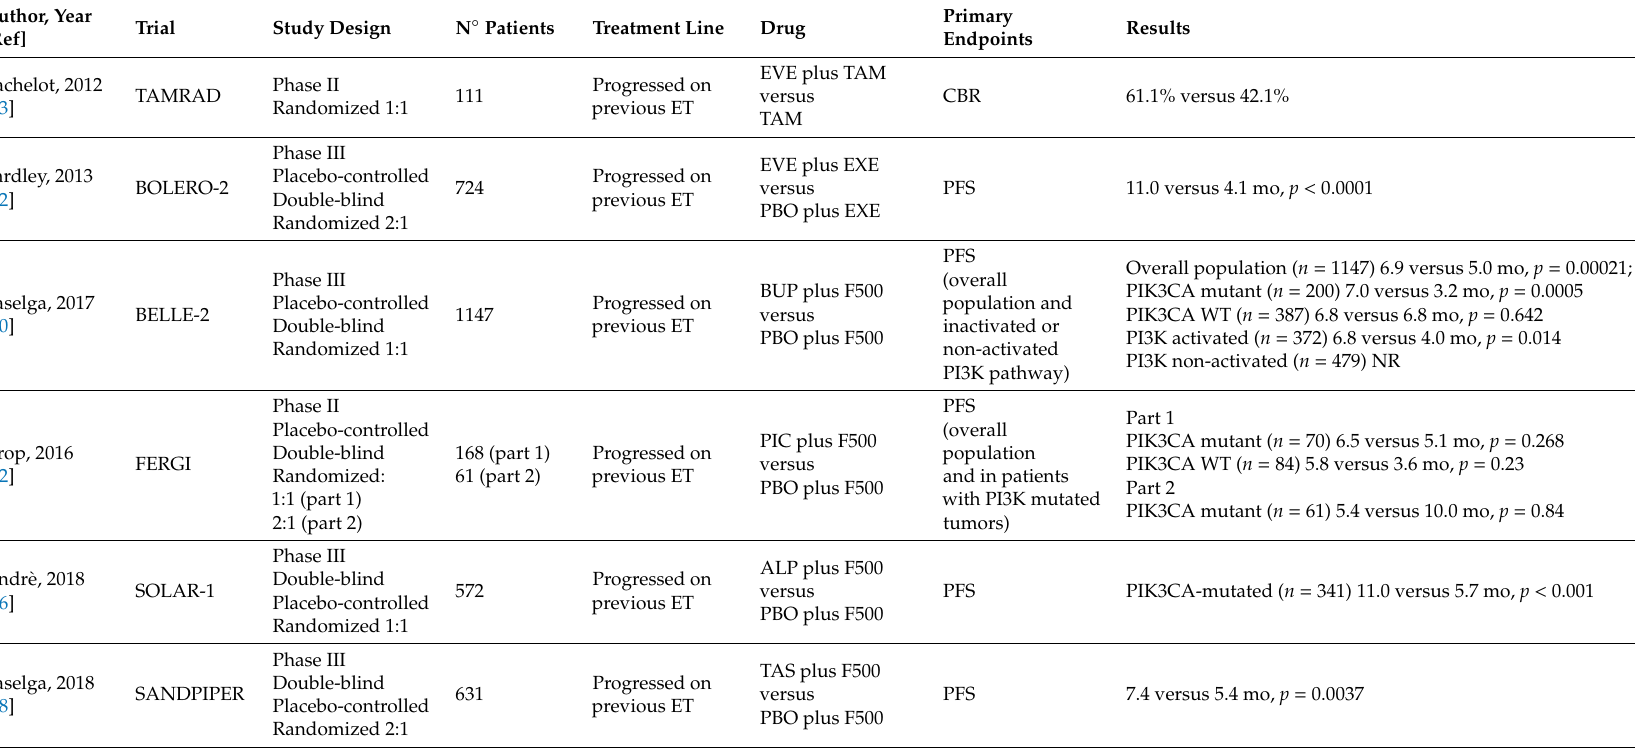
Table 1. Pivotal trials on the phosphatidylinositol 3-kinase (PI3K) / protein kinase B (AKT) / mammalian target of rapamycin (mTOR)